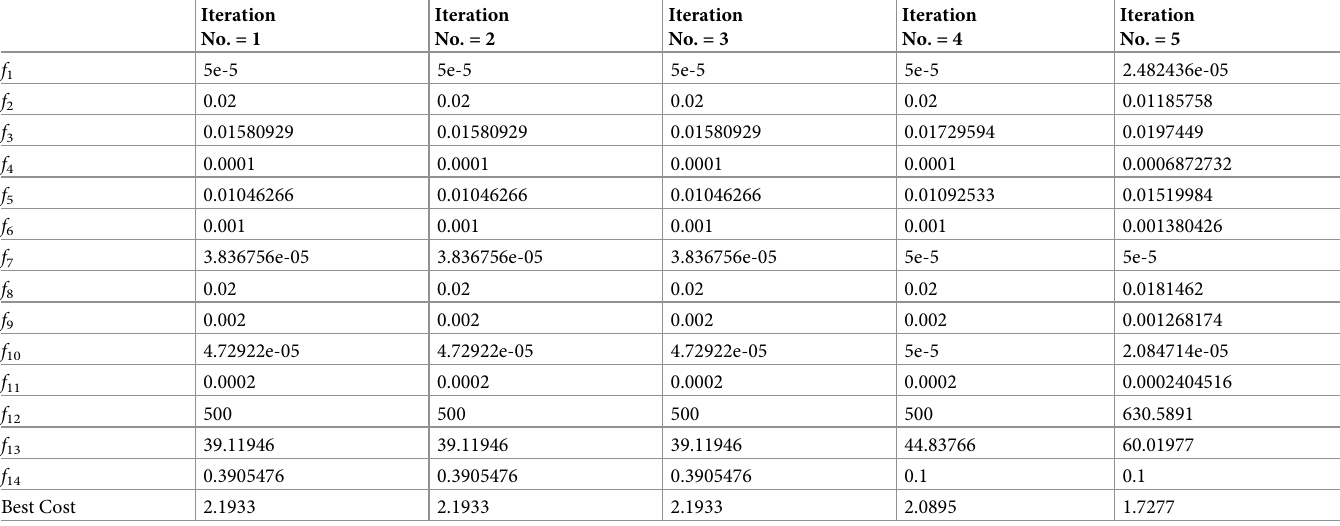
Table 3. The achieved results when using the Jaya algorithm. Iteration No. = 1